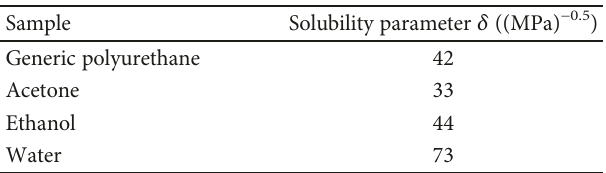
Table 2: Solubility parameter of Estane, acetone, ethanol, and water as a summation of square Hildebrand and Scott components δ , δ , and δ . Data from the handbook of Hansen solubility d p h parameters